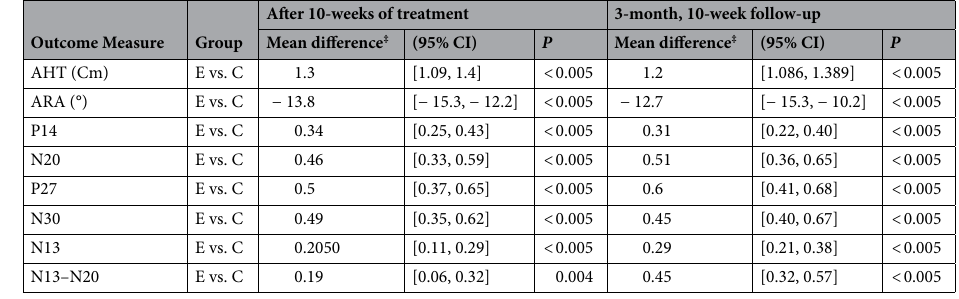
Table 2. Differences between treatment groups on each outcome measure after 10-weeks of treatment and at 3-month follow up after the 10-weeks of treatment. Anterior head translation (AHT) in centimeters, lordosis C2–C7 absolute rotation angle (ARA) in degrees, 95% confidence interval (CI). E experimental group, C control group, CI confidence